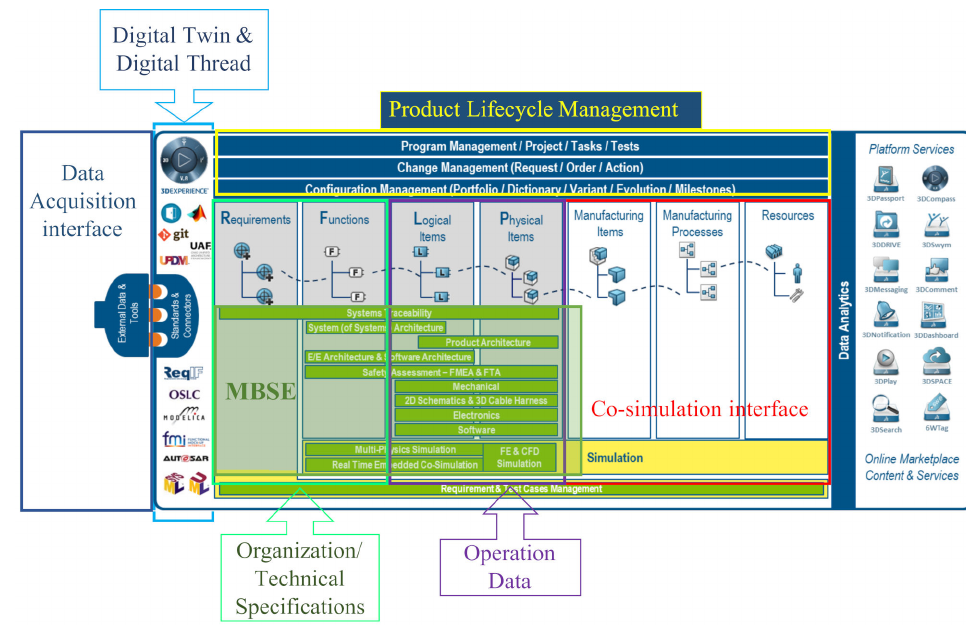
Figure 9. Proposed architecture for enabling digital twin/thread application to enhance digital continuity and